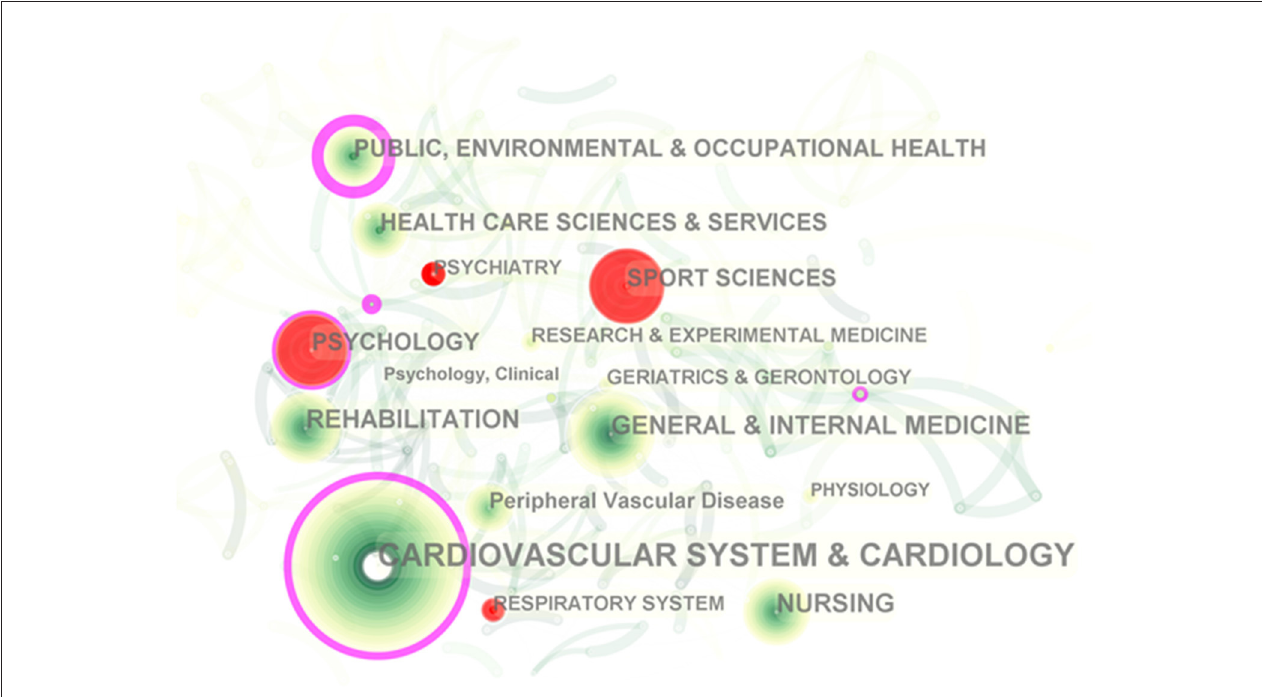
FIGURE 3 | Subject category co-occurrence of publications about cardiac rehabilitation (CR) and related research. Circle node represents subject category; link between nodes represents interdisciplinary interaction of the literature.